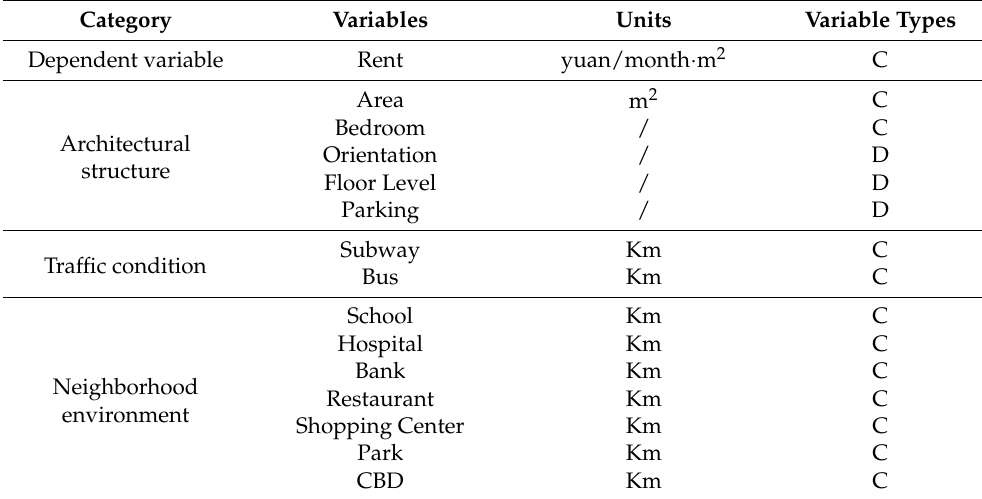
Table 3. The information on the factors that influence private housing rental prices. Category Variables